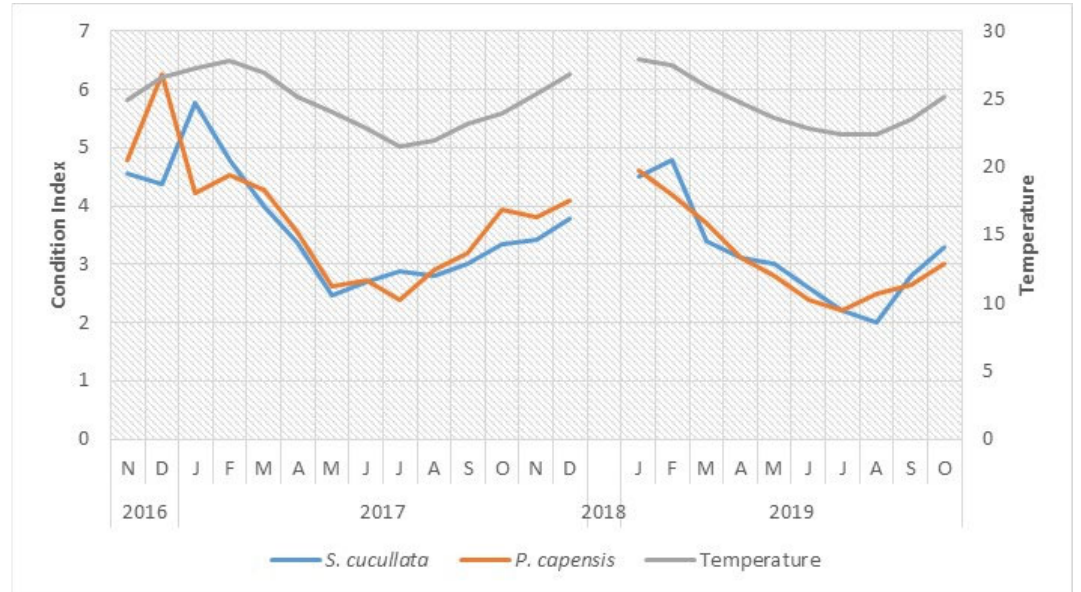
Figure 4. Monthly changes in temperature and the condition index of Pinctada capensis and Saccostrea cucullata from Inhaca Island (sample size per month is 50).